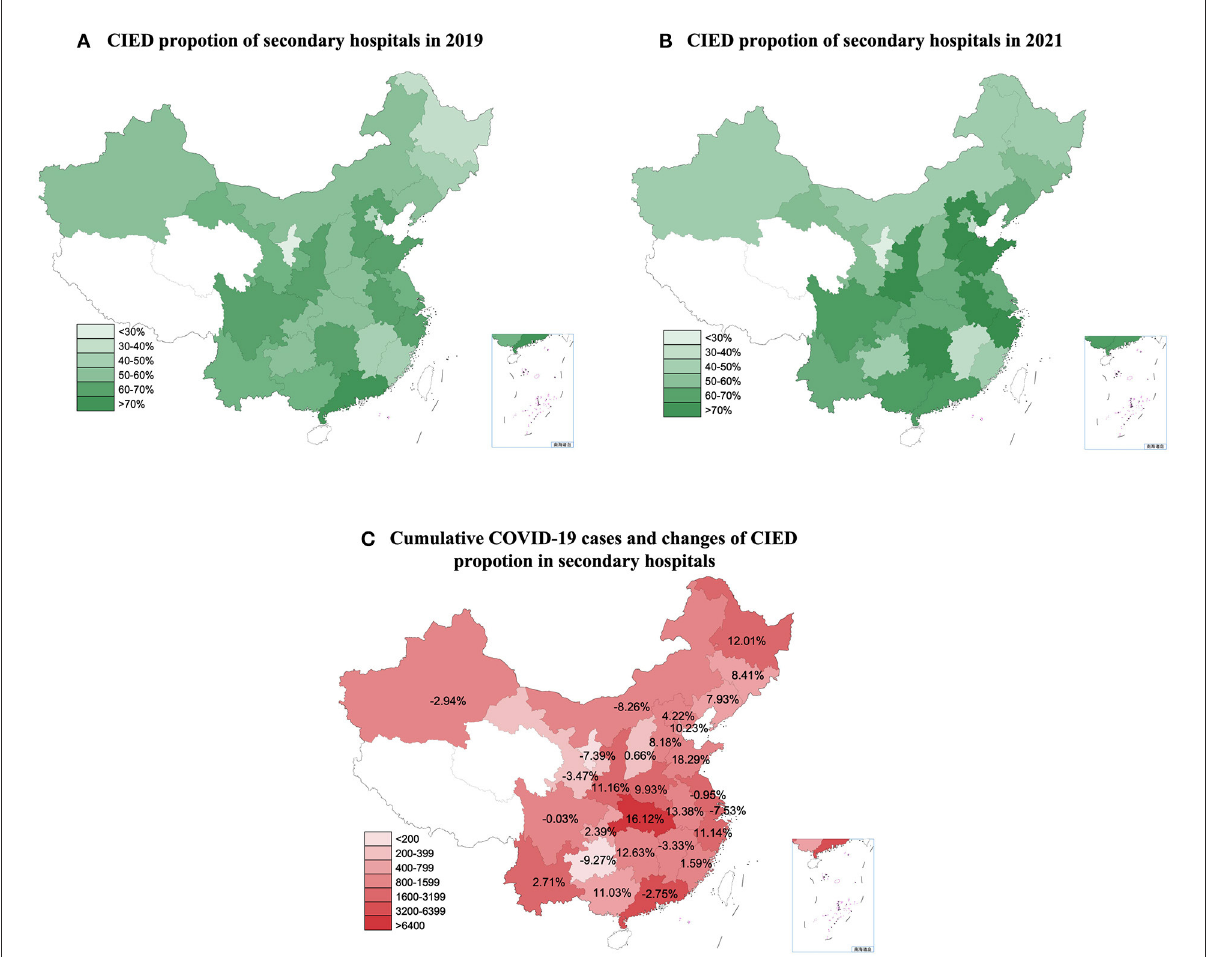
FIGURE4 The proportion of CIED implantations in secondary centers in 2019 and 2021 and the relationship between the changes and cumulative COVID-19 cases. CIED, cardiac implantable electronic device. COVID-19, Coronavirus disease 2019. (A) CIED proportion of secondary hospitals in 2019. (B) CIED proportion of secondary hospitals in 2021. (C) Cumulative COVID-19 cases and changes CIED proportion of secondary